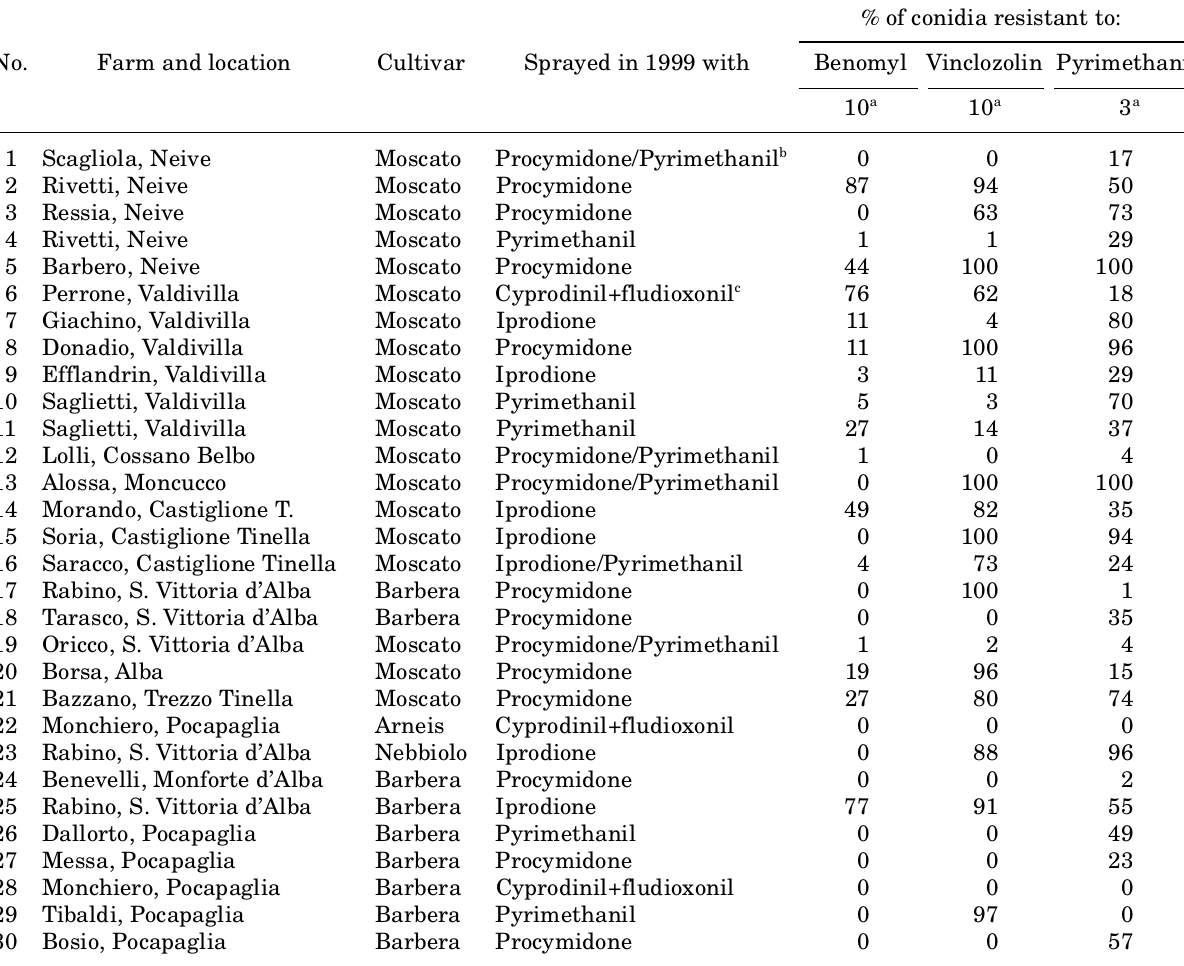
Table 3. Results of a survey in 1999 to detect resistance of Botrytis cinerea to different classes of botryticides.